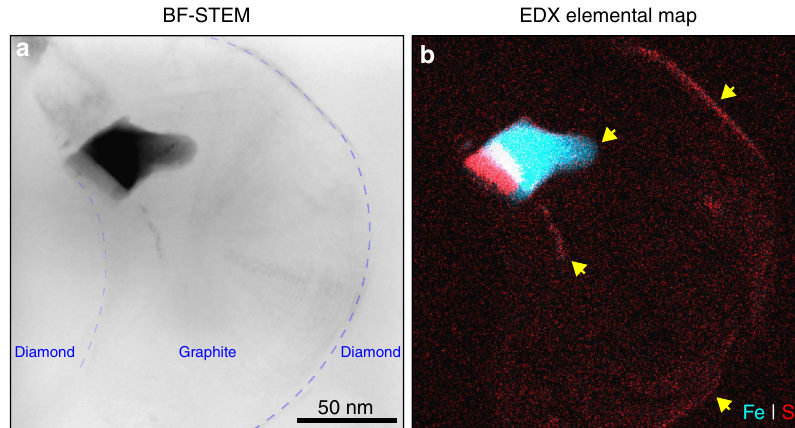
Fig. 4 Electron micrograph and chemical map of an inclusion in a graphitized region. a Bright- fi eld (BF) STEM image and b chemical (EDX) map from graphite growth in diamond matrix around an inclusion. Blue dashed lines indicate the diamond – graphite boundary. The yellow arrows point out the Fe – S- rich regions in graphite. Notice the clear rounded form of the inclusion in graphitized part indicating partial